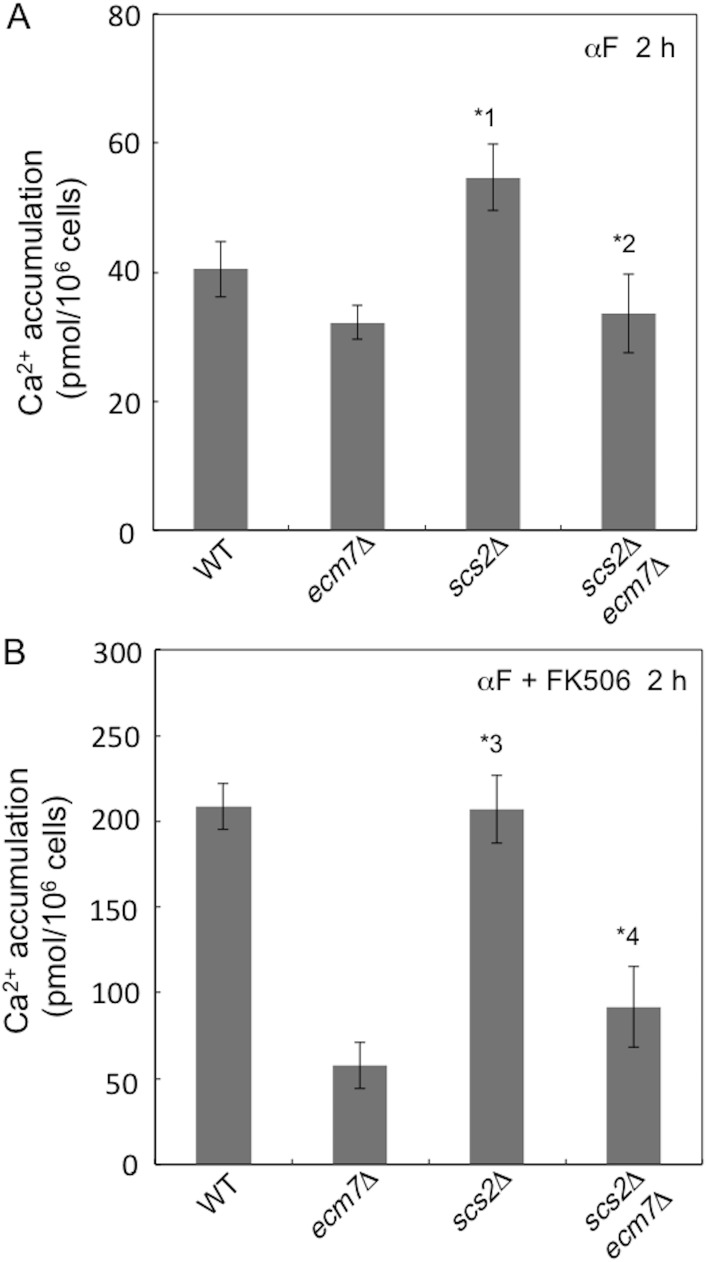
The deletion of SCS2 increases Ca2+ accumulation in calcineurin-active cells, but not in calcineurin-inactivated cells.Experimental conditions and procedures were the same as those described in the legend to Fig 2. Cells were incubated for 2 h with 6 μM α-factor only (A) or with 6 μM α-factor and 2.0 μg/ml FK506 (B). *1, p < 0.05 (scs2Δ vs. WT); *2, p > 0.05 (scs2Δ ecm7Δ vs. ecm7Δ); *3, p > 0.05 (scs2Δ vs. WT); *4, p < 0.05 (scs2Δ ecm7Δ vs. ecm7Δ). Data are the mean ± SD of three independent experiments.